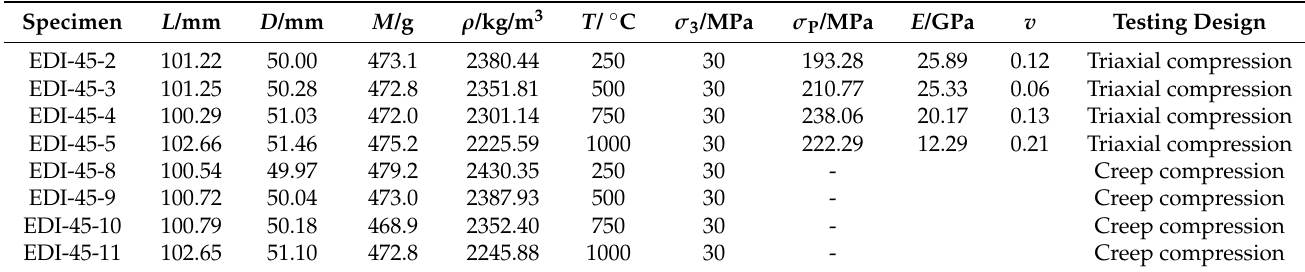
Table 1. Basic physical properties of sandstone specimens.